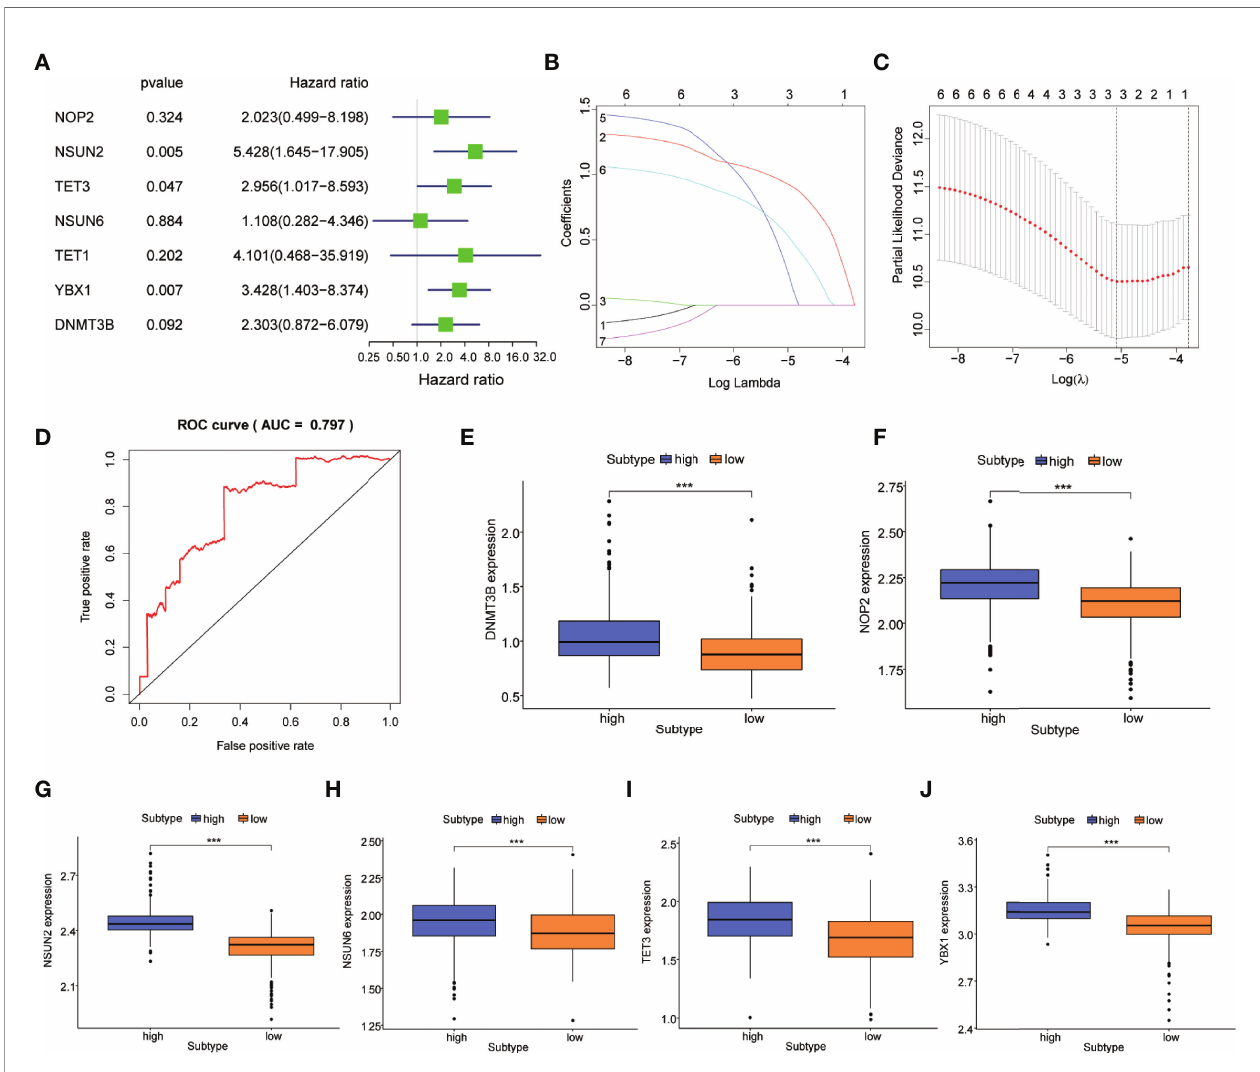
FIGURE 2 | Construction of the m5C prognostic model in PCa. (A) m5C regulatory genes related to the prognosis of PCa were identi fi ed by univariable Cox regression in a forest plot. (B) LASSO Cox regression analysis of m5C regulatory genes. (C) The parameter selection was tuned by cross-validation in the LASSO Cox regression. (D) ROC curves showed the prognostic performance of the m5C prognostic model. Difference in the expression of m5C regulatory genes including (E) DNMT3B , (F) NOP2 , (G) NSUN2 , (H) NSUN6 , (I) TET3 , and (J) YBX1 between high-risk and low-risk subtypes. P -values was shown as *** P <